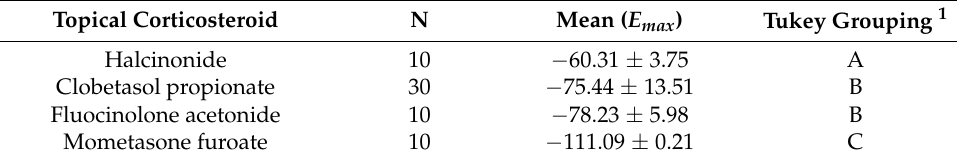
Table 5. Pairwise E max comparisons. Topical Corticosteroid N Tukey Grouping